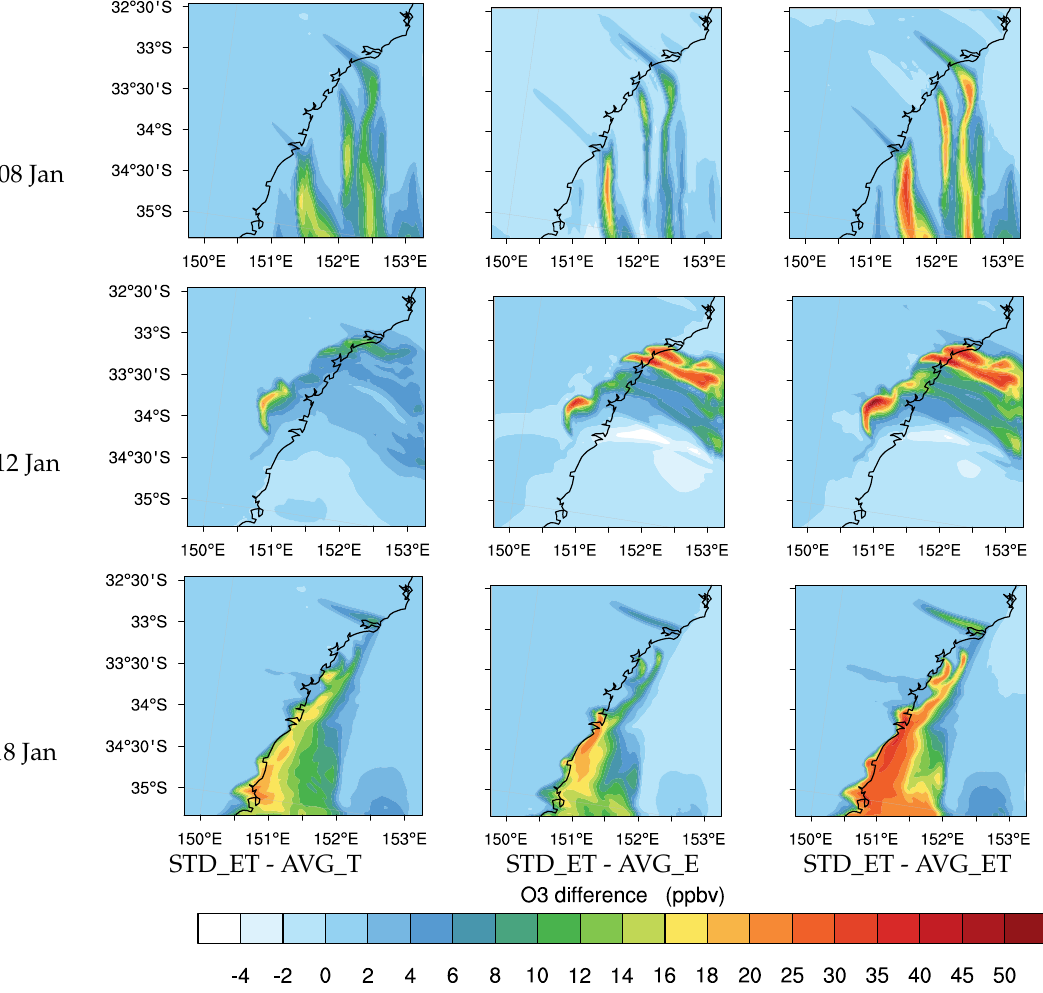
Figure 14. Difference in ozone between standard run and scenario runs during extreme heat days at 3:00 p.m. local